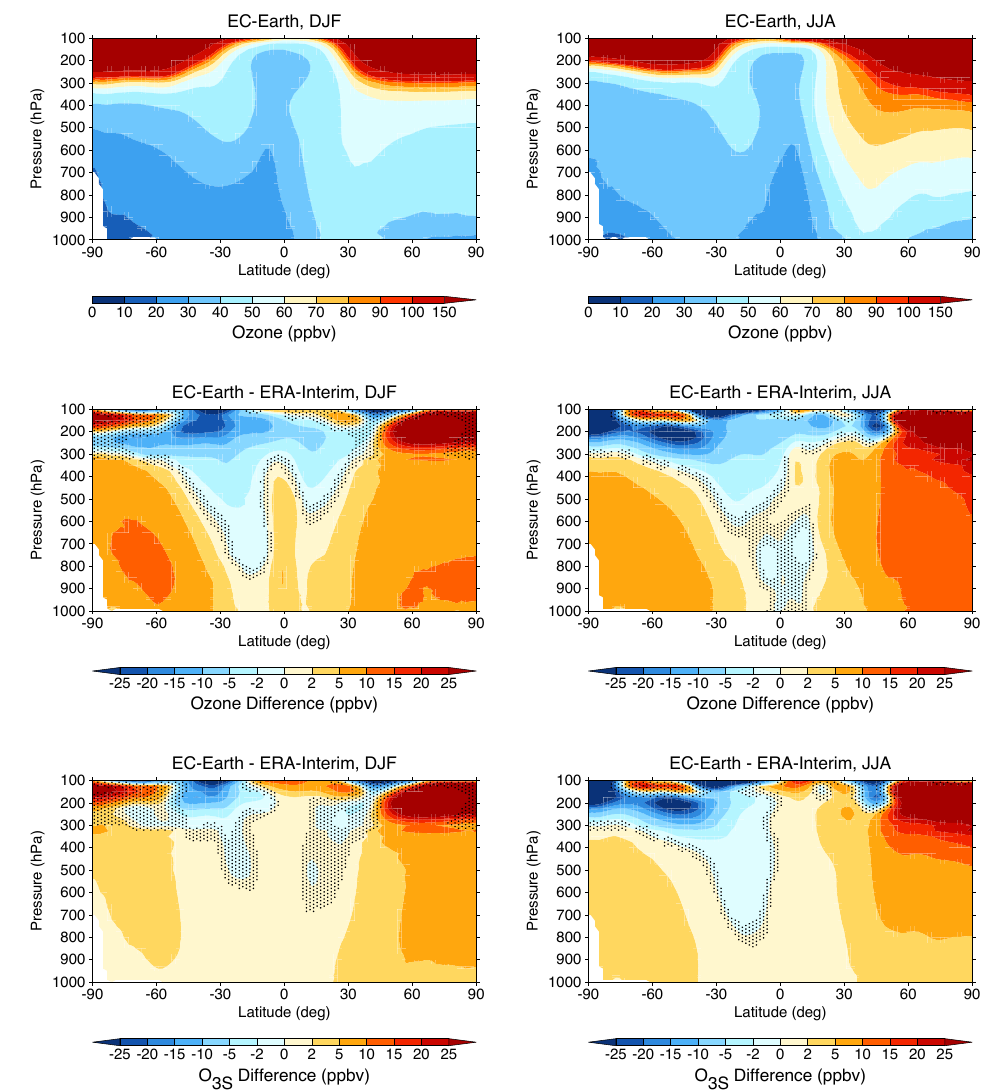
Figure 7. Zonal mean O 3 mixing ratios in the reference EC-Earth simulation (top), the differences compared to the corresponding ERA- Interim simulation (middle), and the contribution from the stratospheric O 3 tracer (O 3S ) to these differences (bottom) for boreal winter (left) and boreal summer